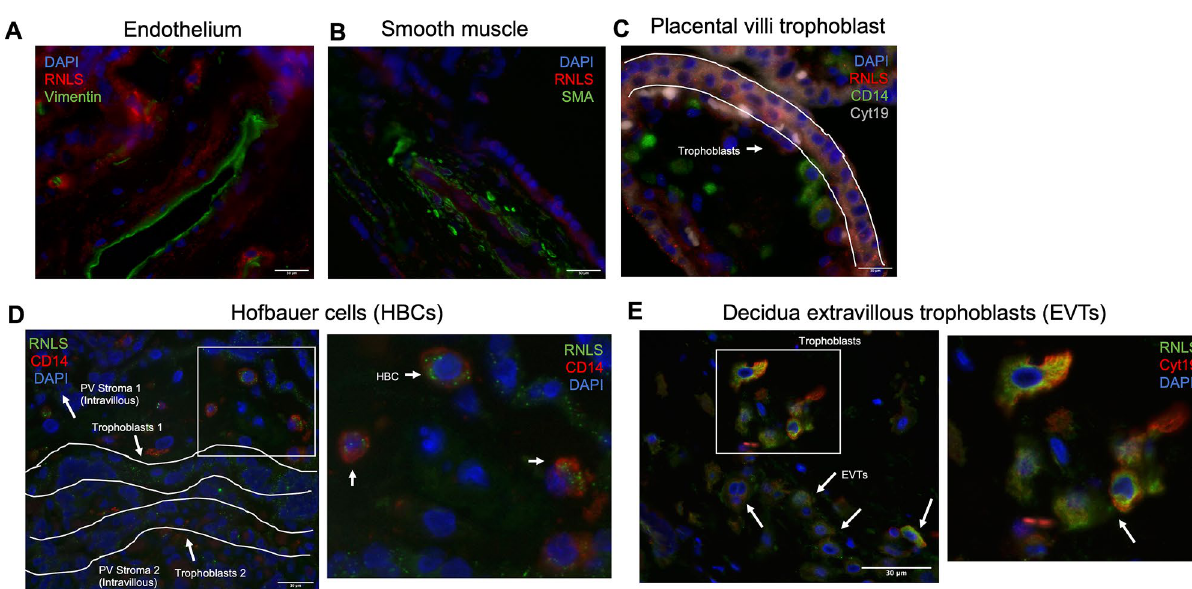
Figure 4. RNLS immunoreactivity is present in trophoblasts and macrophages within placental villi and decidua. (A) Immunofluorescence co-labeling with RNLS (red), vimentin (green, endothelium), DAPI (blue) of placental villi at 60x. (B) RNLS (red), SMA (green, smooth muscle actin, smooth muscle), and DAPI (blue) of placental villi at 60x. (C) RNLS (red), CD14 (green, Hofbauer cell), Cyt19 (white, cytokeratin 19, trophoblast), DAPI (blue) in placental villi at 60x. (D) RNLS (green), CD14 (red, Hofbauer cell) and DAPI (blue) of placental villi trophoblasts at 60x. (E) RNLS (green), Cyt19 (red, extravillous trophoblast, EVT), DAPI (blue) of placental decidua at